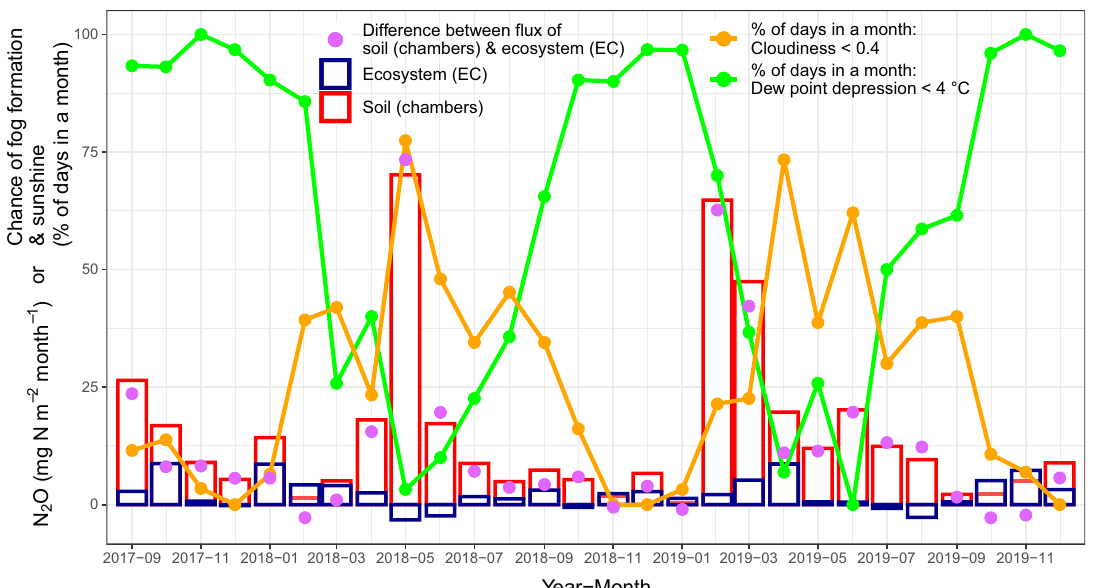
Fig. 6 N 2 O fl uxes (soil and eddy covariance) related to the chance of sunshine and fog formation. Relationship between the monthly sum of soil and EC fl uxes of N 2 O (mg N m − 2 month − 1 ) with the percentage of days with a high chance of sunshine (cloudiness ratio <0.4) and fog formation (dew point depression <4 °C). During the drought onset (May 2018) and dry-minor (June – July 2019) periods photochemical reactions might play an important role in decreasing ecosystem (EC) fl ux of N 2 O, whereas during the Wet (September – November 2017) and freeze-thaw (February 2019) periods absorption on wet surfaces and water droplets could be the reason for the decrease in EC N 2 O fl ux. The difference between the soil and EC N 2 O fl uxes is negatively correlated with the percentage of days in a month with dew point depression <4 °C, whereas a positive trend is observed both in the difference between soil and EC fl ux and the share of sunny days (cloudiness ratio < 0.4) in a (Supplementary Fig. 8). Nevertheless, the absence of concen- tration pro fi le measurements and our simpli fi ed approach to the storage calculation may have contributed to the discrepancy between the soil chamber and EC measurements.